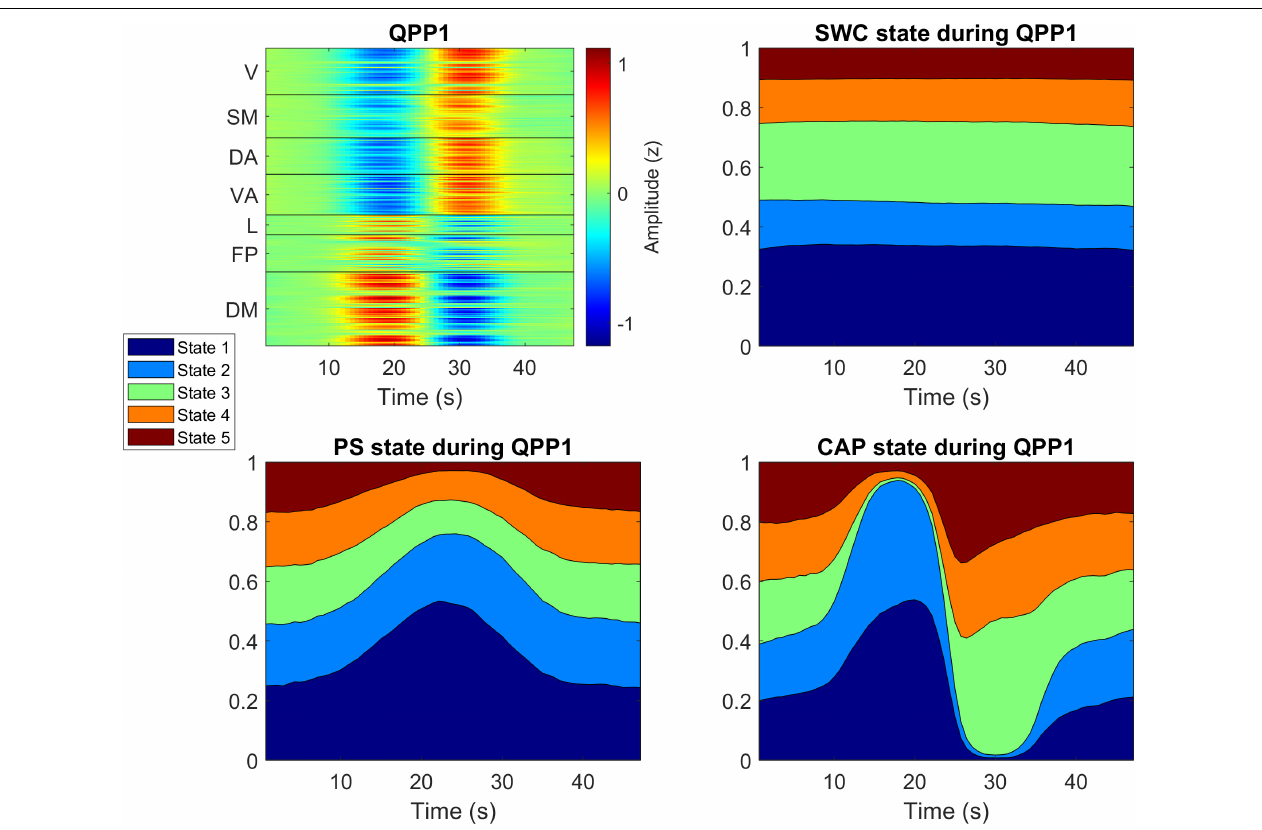
FIGURE 4 | Comparison of most likely states during QPP1. Top-left shows spatiotemporal QPP1 template with timepoints on the x-axis and space (Glasser’s 360 parcels) on the y-axis and colors corresponding to z-score BOLD signal amplitude. The other three panels show the same timepoints on the x-axis with the likelihood of being in each state plotted on the y-axis with the colors corresponding to the five brain states identified by each dynamic analysis method. A video representation of the QPP1 template mapped to a 3D brain surface can be found in Supplementary Materials